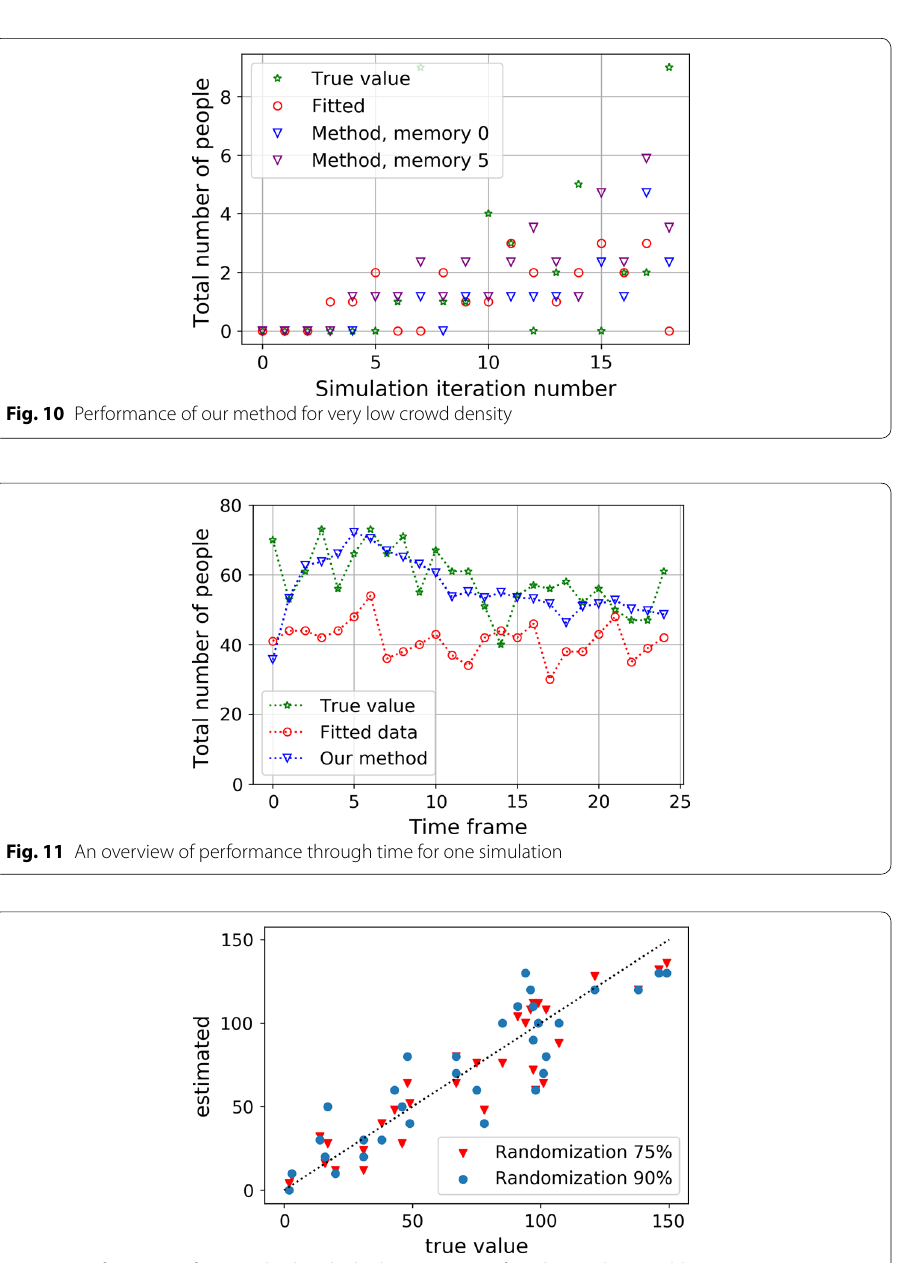
Fig. 12 Performance of our method under high percentage of randomized MAC